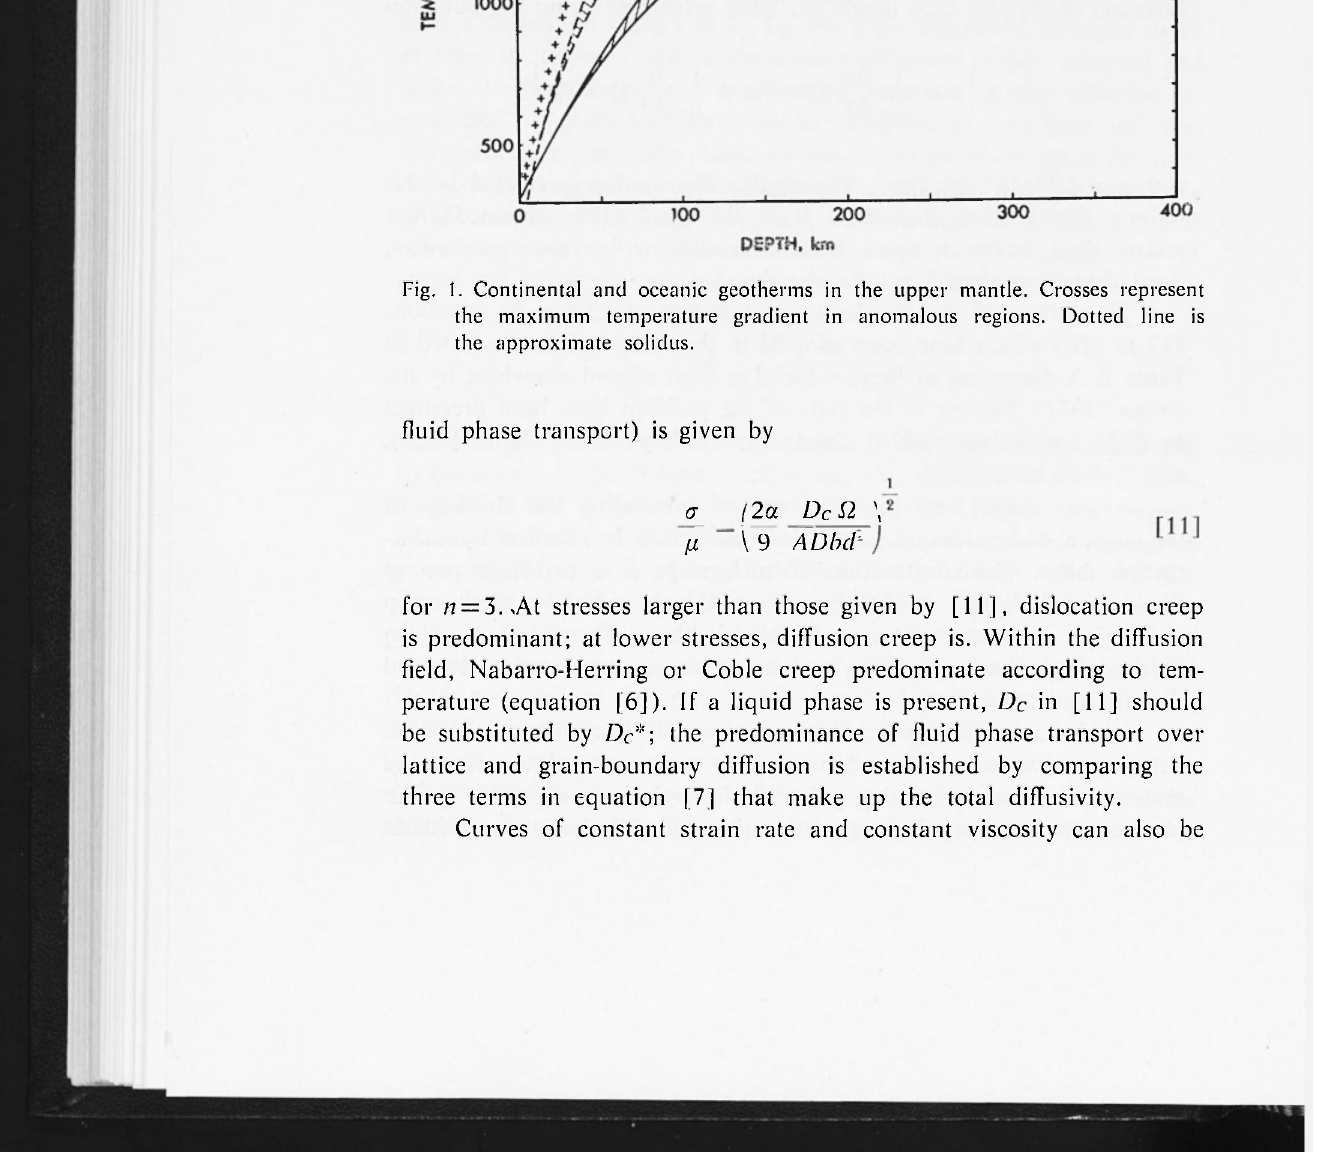
Fig. 1. Continental and oceanic geotherms in the upper mantle. Crosses represent the maximum temperature gradient in anomalous regions. Dotted line is the approximate